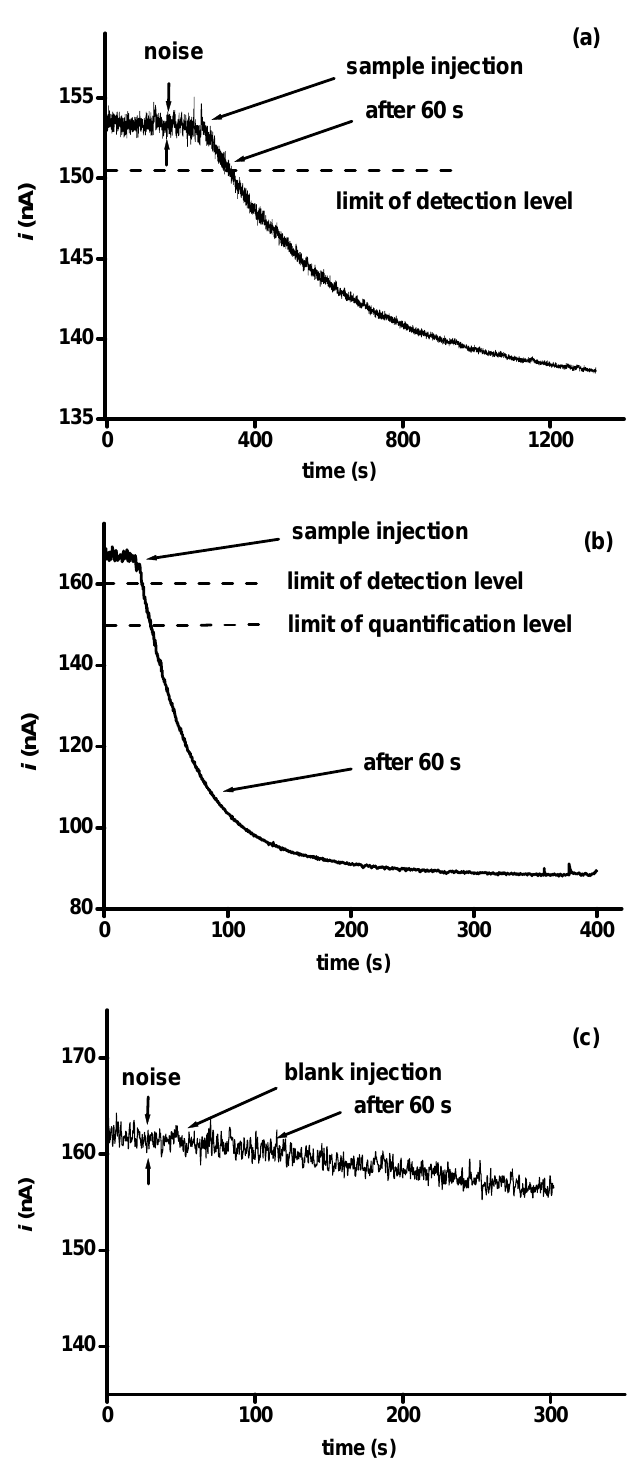
Figure 2. The curves represent following of AChE based biosensor inhibition by organophosphate paraoxon. The graph marked by letter a was obtained by injection 20 pg of paraoxon; the one marked by letter b is meaning for injection 2 ng of paraoxon. The most important moments of analysis (limit of detection and quantification leves, noise, moment of sample injection and time moment equal to 60 s after sample injection) are indicated in graphs by arrows and lines The graph marked by letter c represents blank application, drift of background signal could be observed in this